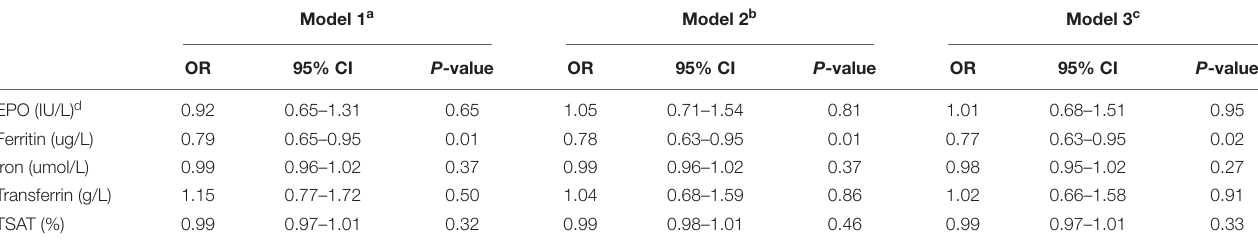
TABLE 5 | Binomial logistic regression analyses of the association of individual iron status parameters and erythropoietin with a high performance on the VAT